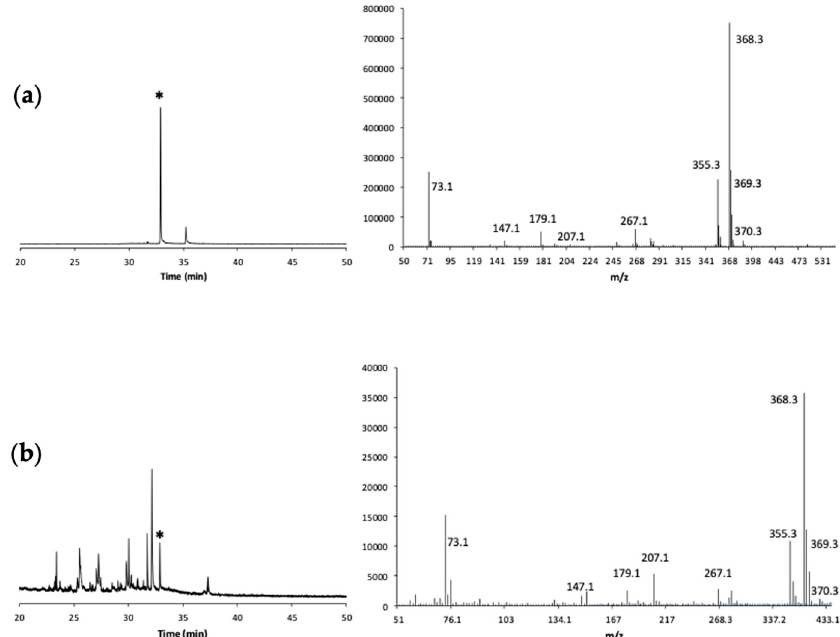
Figure 3. Representative GC chromatograms and MS spectra, in EI mode at 70 eV, of derivatives of ( a ) epicatechin standard and ( b ) epicatechin in a selected real sample. The epicatechin peak is marked with an asterisk.